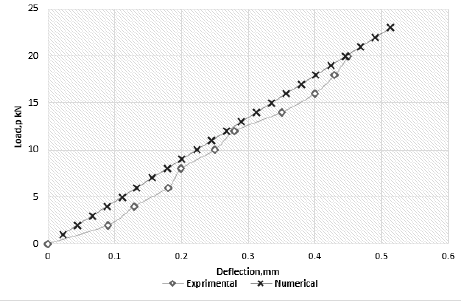
Figure 23. Load–deflection diagram of beam (B1).